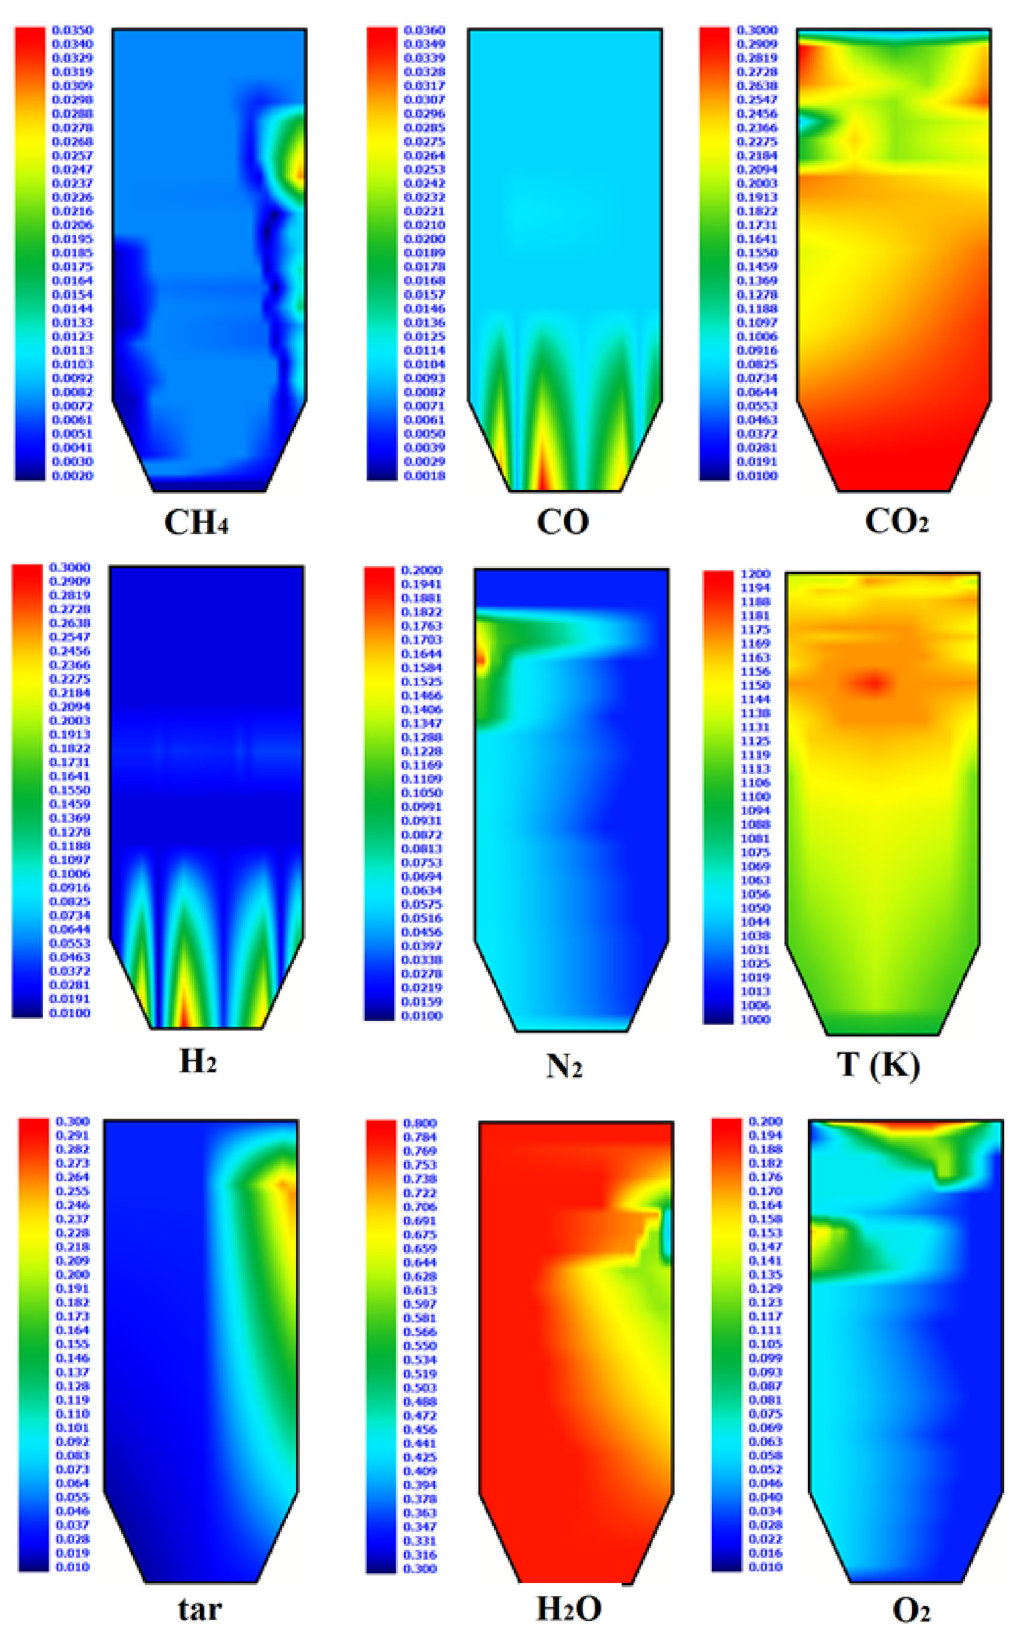
Fig. 4 Contours of the simulated temperature and gas composition distributions along fuel bed